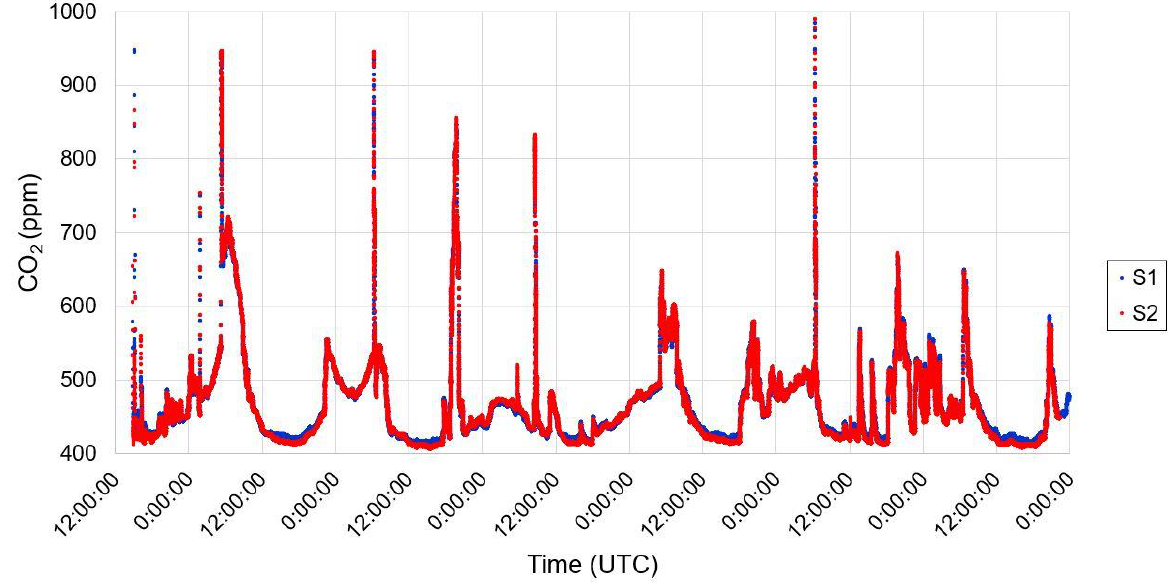
Figure 2. Temporal trend of CO 2 concentration during a week-long test to compare the sensitivity of